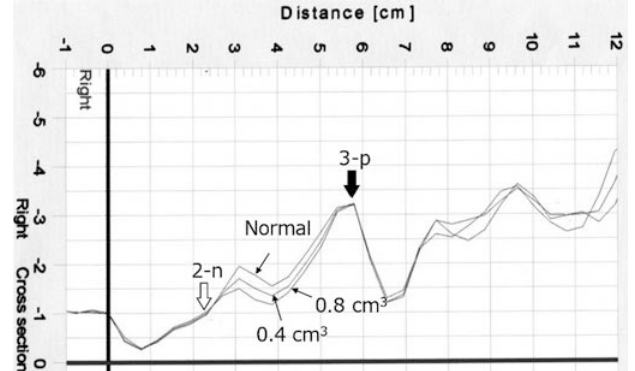
Figure 1 The acoustic rhinometer. SER-2000 Acoustic Rhinometer (Rhino Metrics Co., Ltd., Denmark)